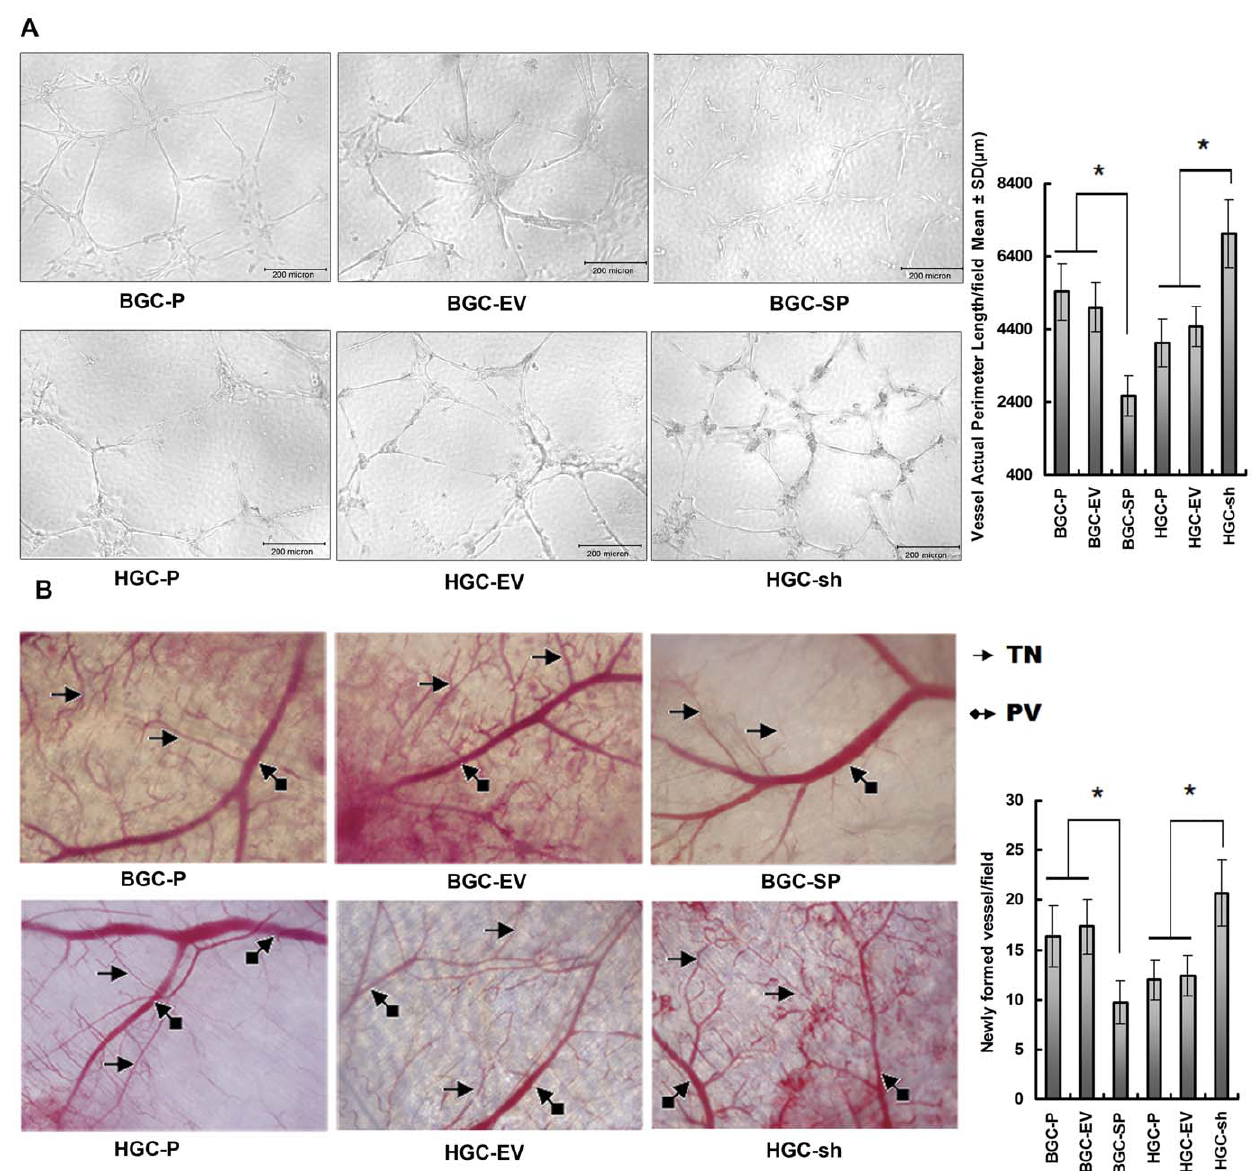
Figure 2. Overexpressed SPARC in gastric cancer cell lines decreases angiogenesis invitro and invivo . ( A ) In vitro angiogenesis: HUVECs were seeded in Matrigel-coated 96-well plates incubated with supernatant harvested from BGC-P and HGC-P cells or transfected clones. The cells were allowed to culture for 36 h on Matrigel in conditional media. The effects of conditioned media on the capillary formed by HUVECs were analysed, and the capillary length was measured. Capillary length data shown are means ( 6 s.d.) of quadruplicate determinations from three separate experiments. *P , 0.05, significant difference from control cells. ( B ) In vivo angiogenesis: BGC-P, BGC-EV, BGC–SP, HGC-P, HGC –EV, or HGC–sh (1 6 10 6 ) were implanted into diffusion chambers and surgically placed underneath the dorsal skin of athymic nude mice. PV, pre-existing vasculature; TN, tumour-induced vasculature. Newly formed vessels were quantified and represented as per field. Columns are means ( 6 s.d.) of quadruplicate fields from three separate experiments. *P , 0.05, significant difference from control cells. doi:10.1371/journal.pone.0044618.g002 endothelial cells in histological tissue sections, which can help to evaluate the degree of tumour angiogenesis. To assess whether altered SPARC expression mediated the microvessel density (MVD), we analysed angiogenesis in xenografts by histological analysis of CD-31. There was no significant difference in MVD between BGC-P (12.5 6 2.3 microvessels/0.145 mm 2 ), BGC-EV